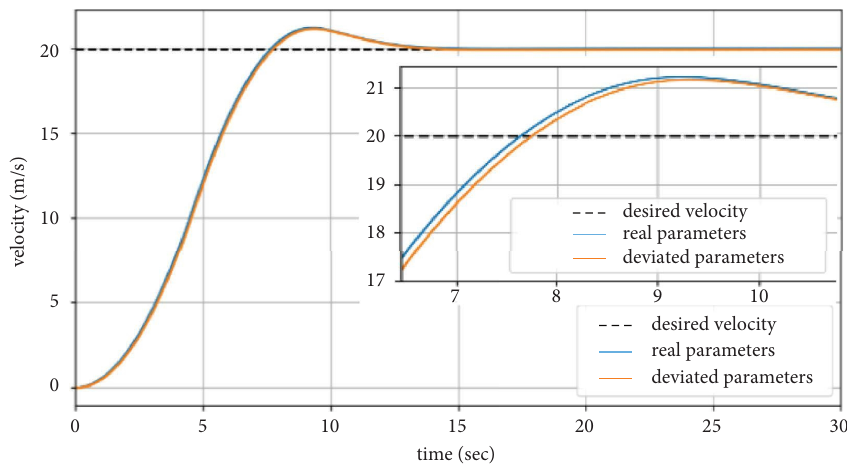
Figure 6: Tracking desired velocity in the presence of uncertainties in the model parameters.